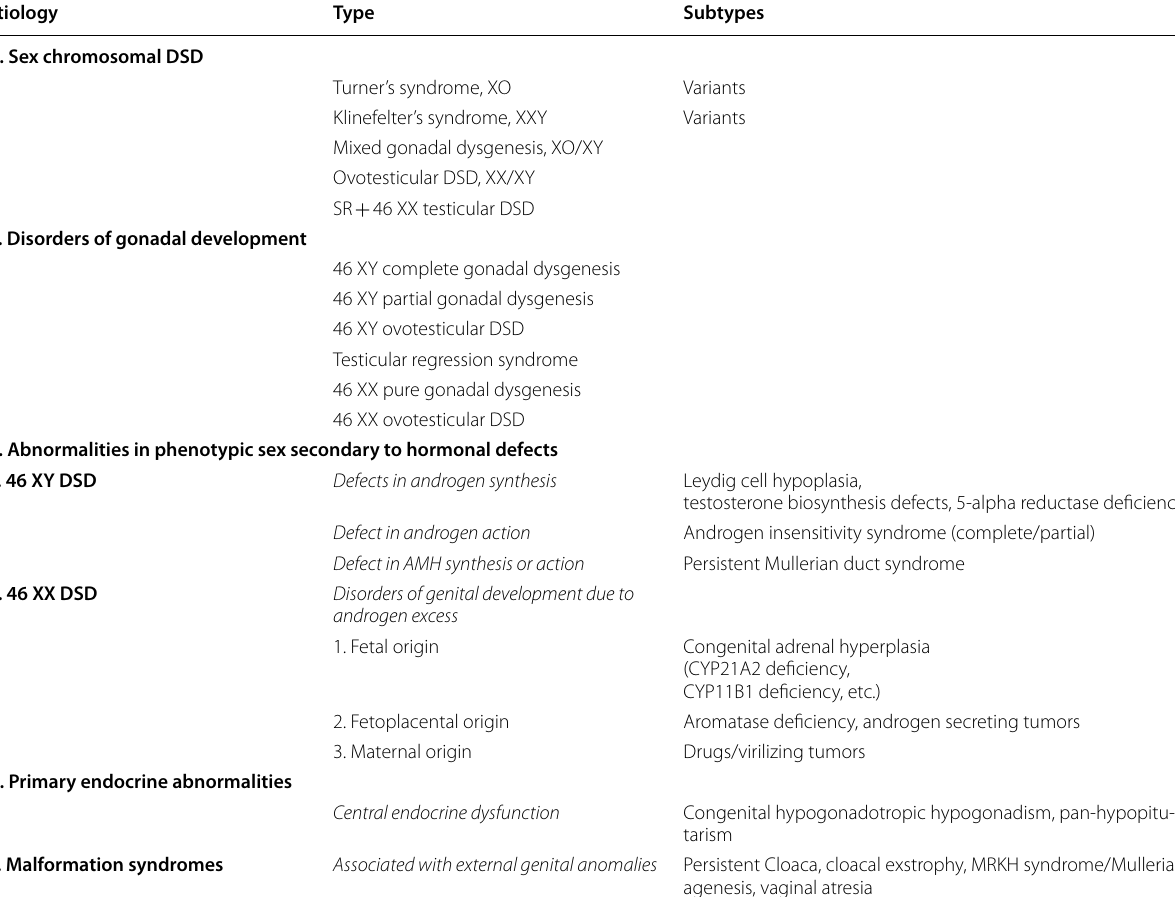
Table 1 The aetiological classification of